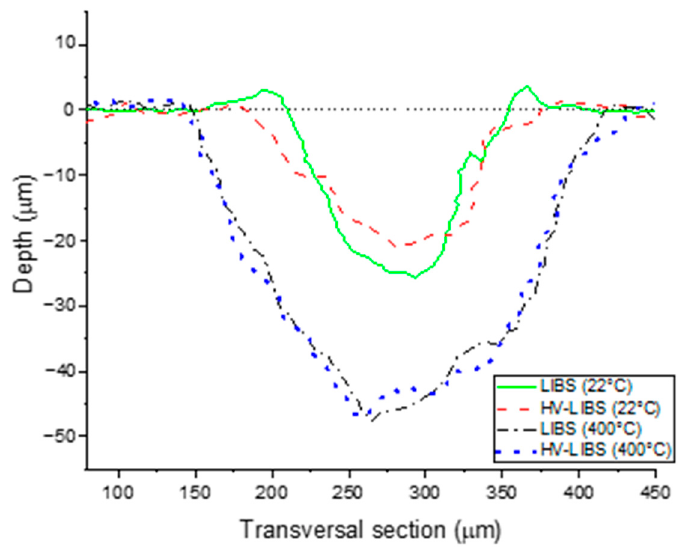
Figure 6. Crater profiles produced by 3 pulses for different experimental schemes: LIBS and HV-LIBS, with the target at room temperature and heated up to 400 °C.